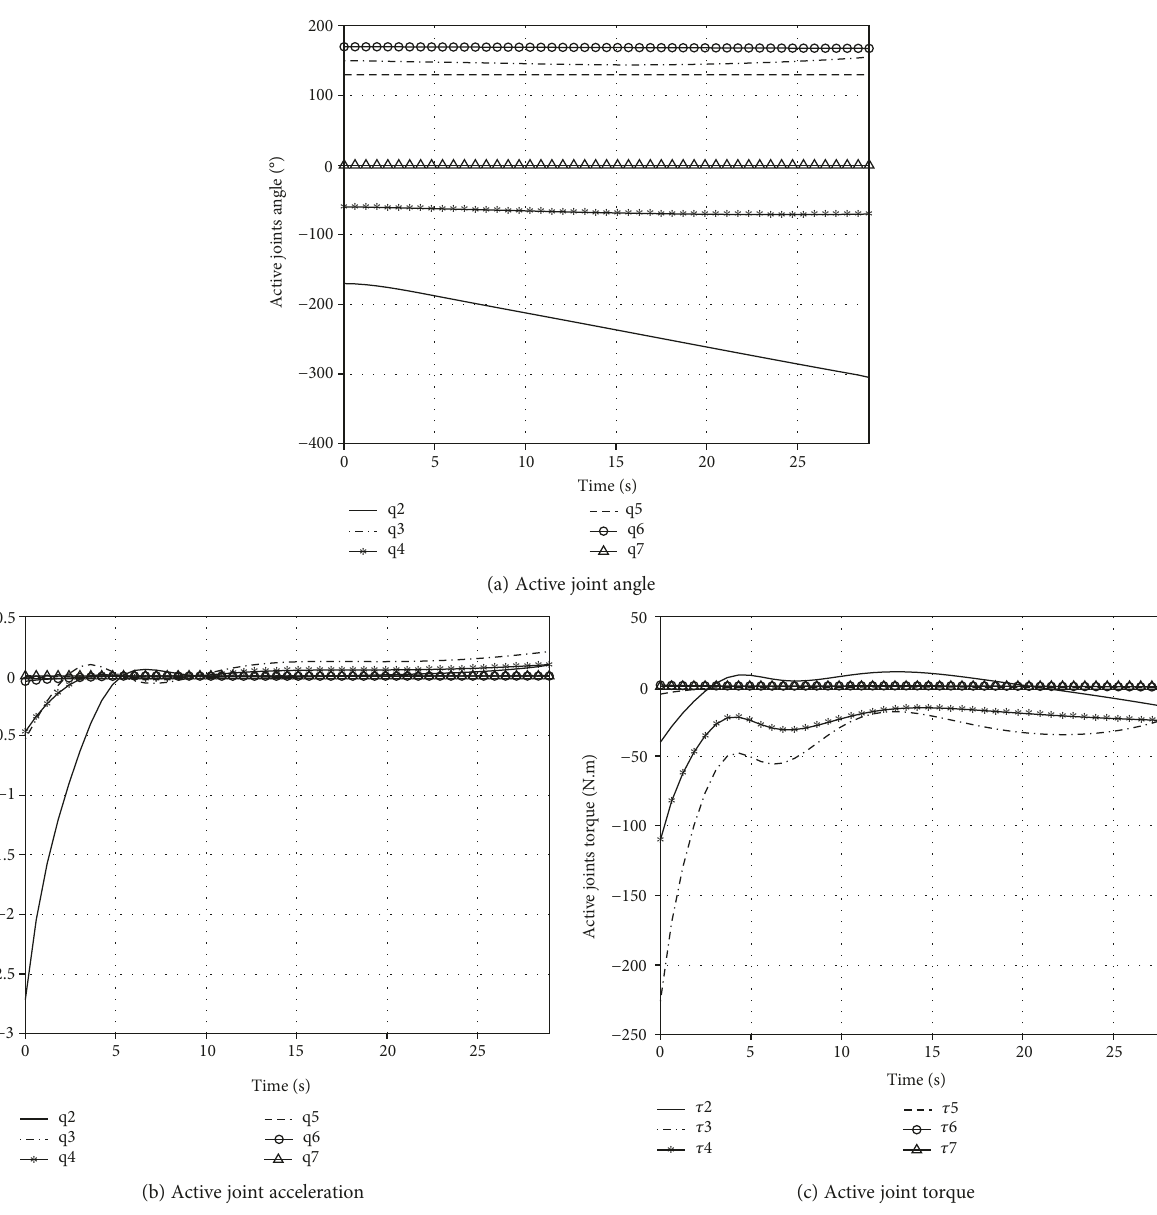
Figure 13: The variations of active joint motion and